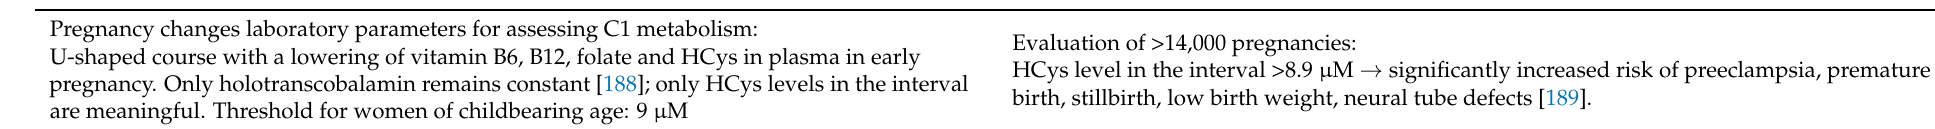
Table A8. Pregnancy and